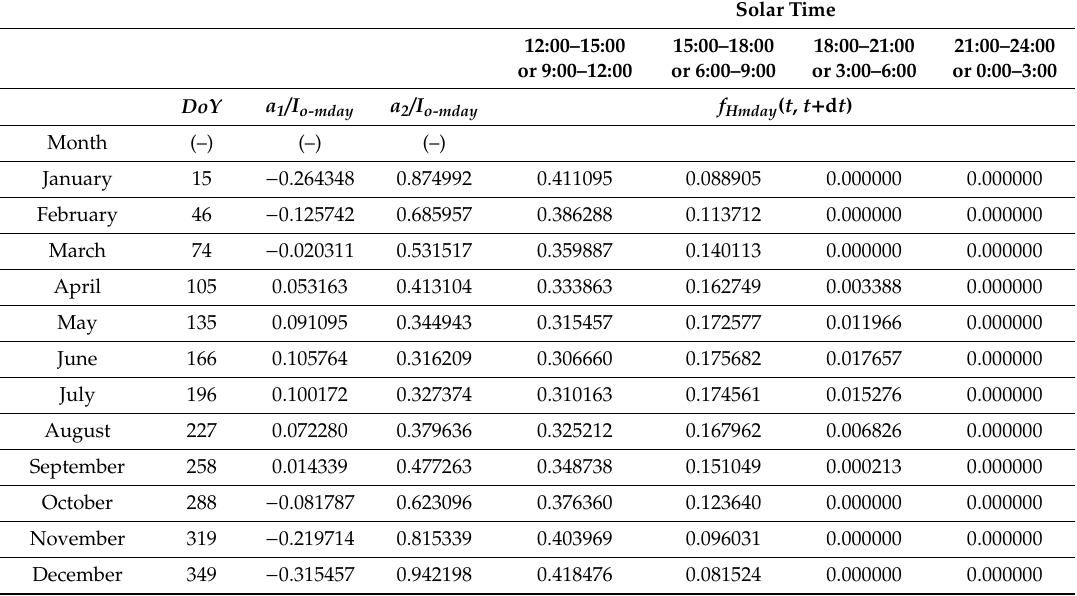
Table 5. Calculation of solar radiation modification factor f Hmday ( t , t + d t ) for the typical current day of the year for the calculation of daily solar irradiation ( DoY ) of each